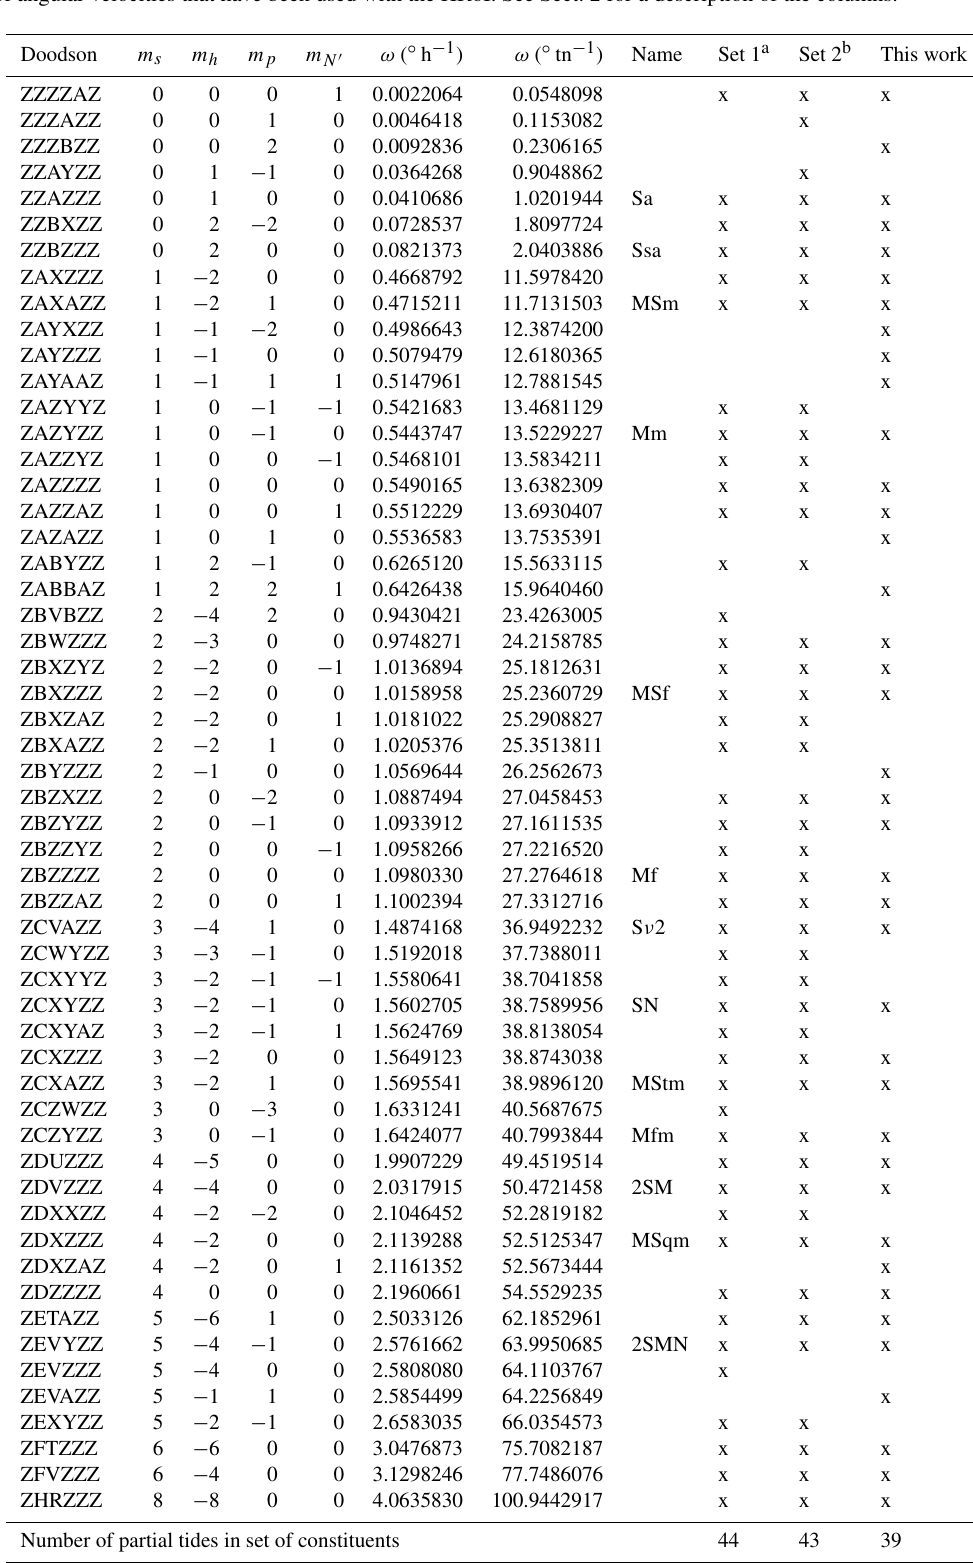
Table 2. Sets of angular velocities that have been used with the HRoI. See Sect. 2 for a description of the